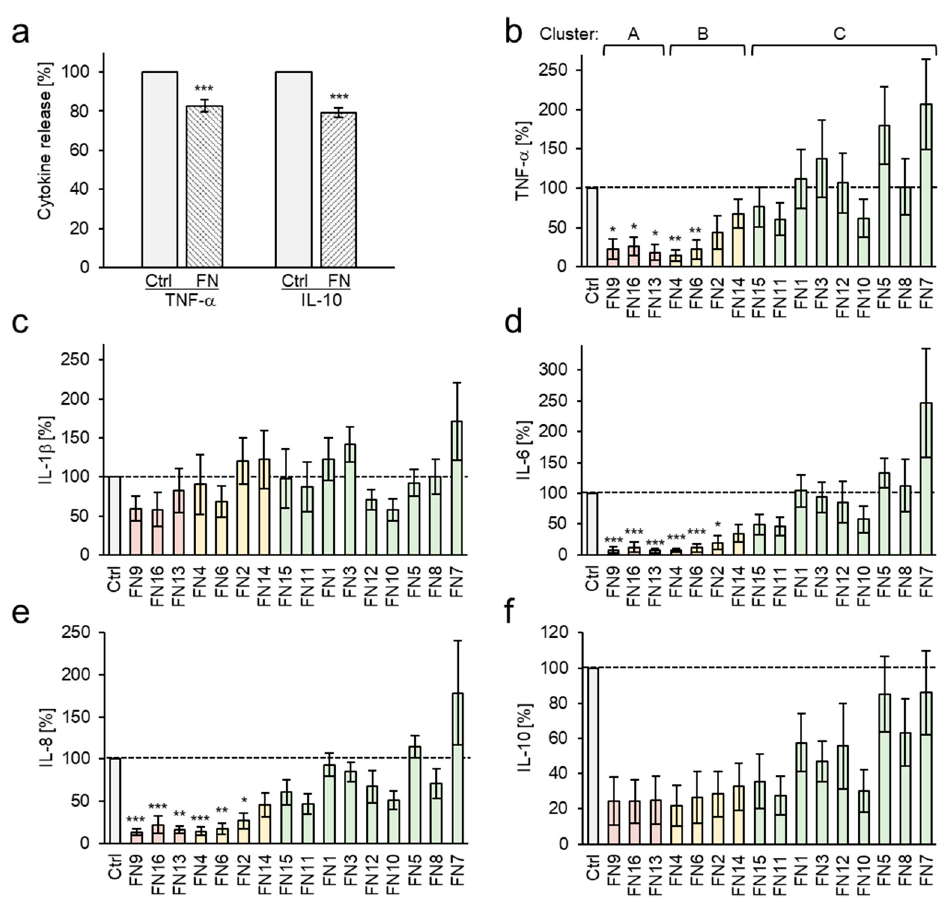
Figure 3. FNs inhibit cytokine production by LPS-stimulated blood and PBMC. ( a ) Inhibition of TNF- α and IL-10 expression by FNs (each at 30 µ g / mL) in LPS-stimulated whole blood. Data are mean ± SEM of 16 FNs; each FN was analyzed in five independent experiments / donors, Wilcoxon test. ( b – f ) Inhibition of TNF- α , IL-1 β , IL-6, IL-8, and IL-10 production by LPS-stimulated PBMC by the respective FN (each at 10 mg / mL). Samples are arranged according to β -ABA content in a descending order. Clusters are from cluster analysis of BAs and LAs compositions in Figure 2c,d: Cluster A (light red) > 30%, Cluster B 30–15% (yellow), and Cluster C (green) < 15% total contents of BAs and LAs. Box-Cox transformation followed by one-way ANOVA and post-hoc Dunnett’s test. All data are mean ± SEM. n = 7 donors; * p < 0.05, ** p < 0.01, *** p < 0.001 compared to LPS-stimulated control groups (Ctrl).